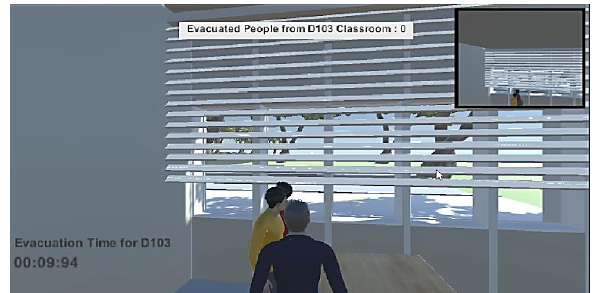
Figure 9. The arrival of Lecturer next to Panic